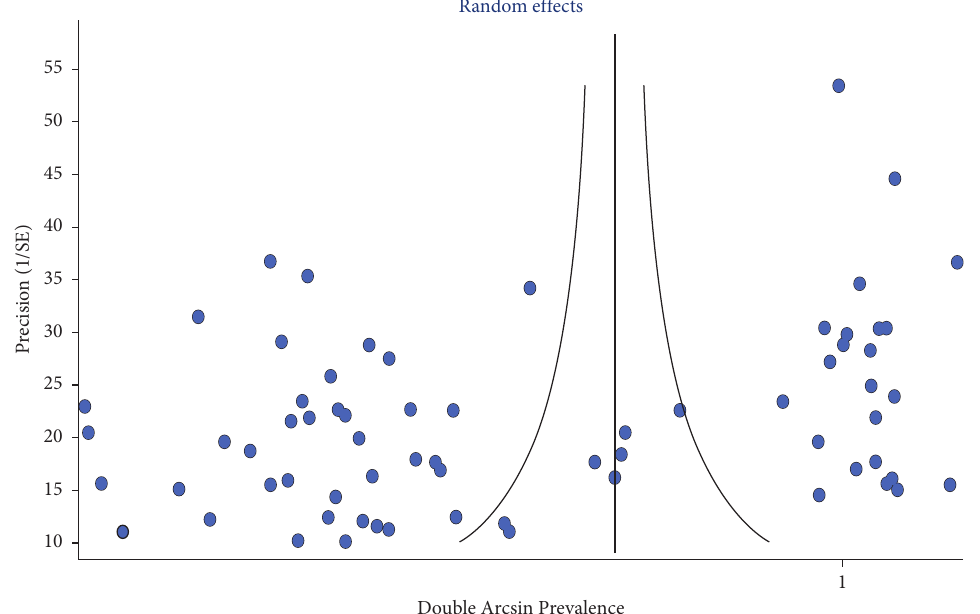
Figure 9: Funnel plot of global tooth-level prevalence of three-rooted PMFM ( Ι ).